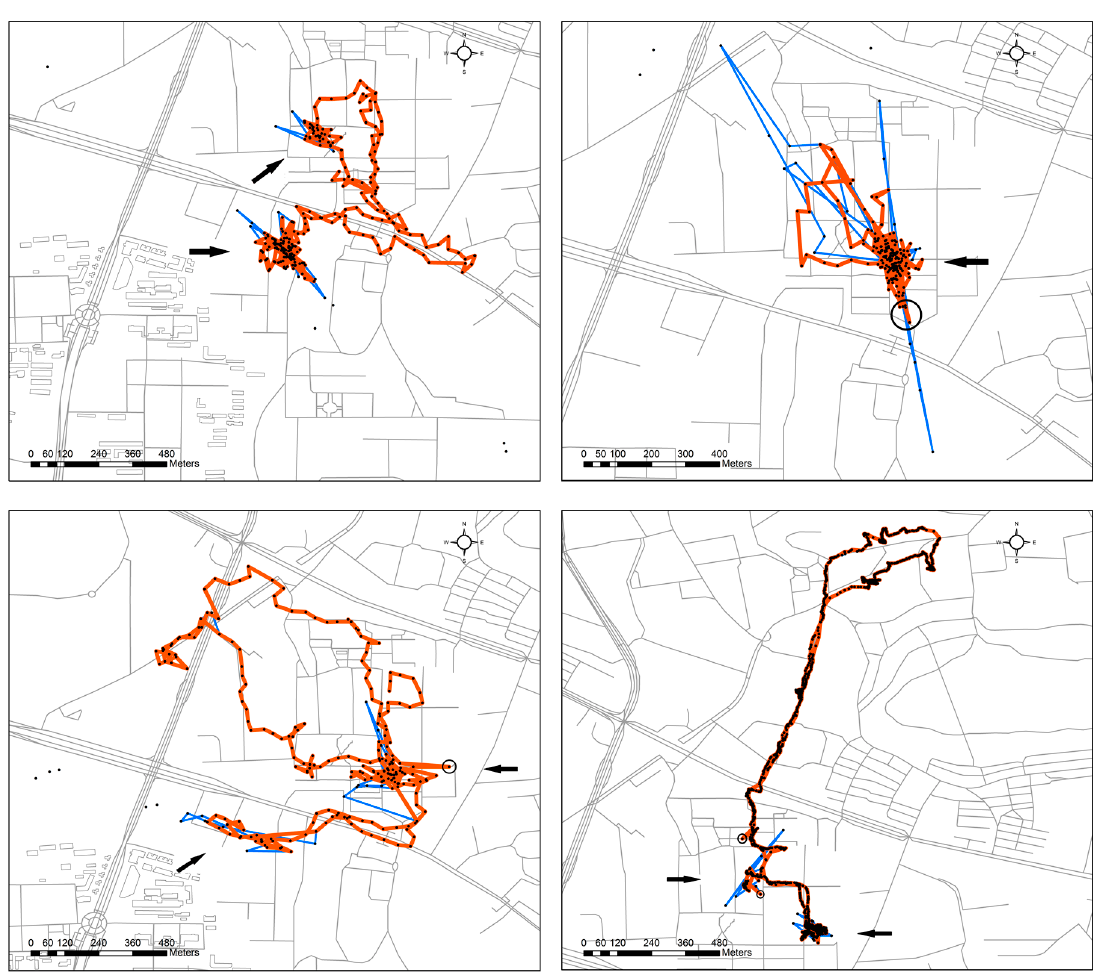
Figure 7. Four volunteers’ trajectories and their VA1 + KSC (blue) and TRDM (red) cleaning results. The black points are the raw data. The arrows show the detected wandering locations. The black circles show suspected outliers which still exist after TRDM.